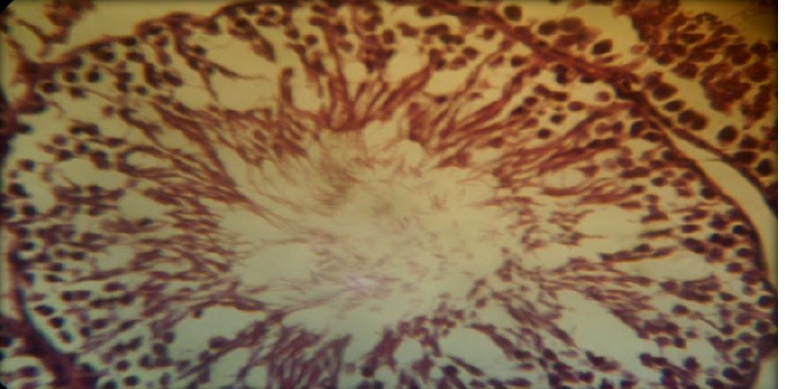
Figure (2): Histological section of testis of rat from control group .Show normal structure of seminiferous tubule (H&E X40).